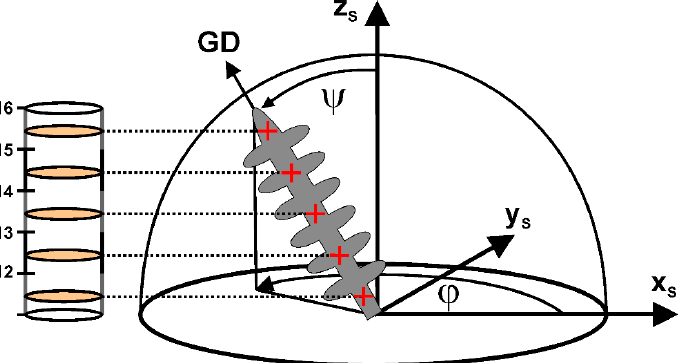
Figure 6. Determination of growth directions for individual dendrites from tomographic image slices. The growth direction (GD) is expressed through polar ψ and azimuth angles ϕ . For details, see